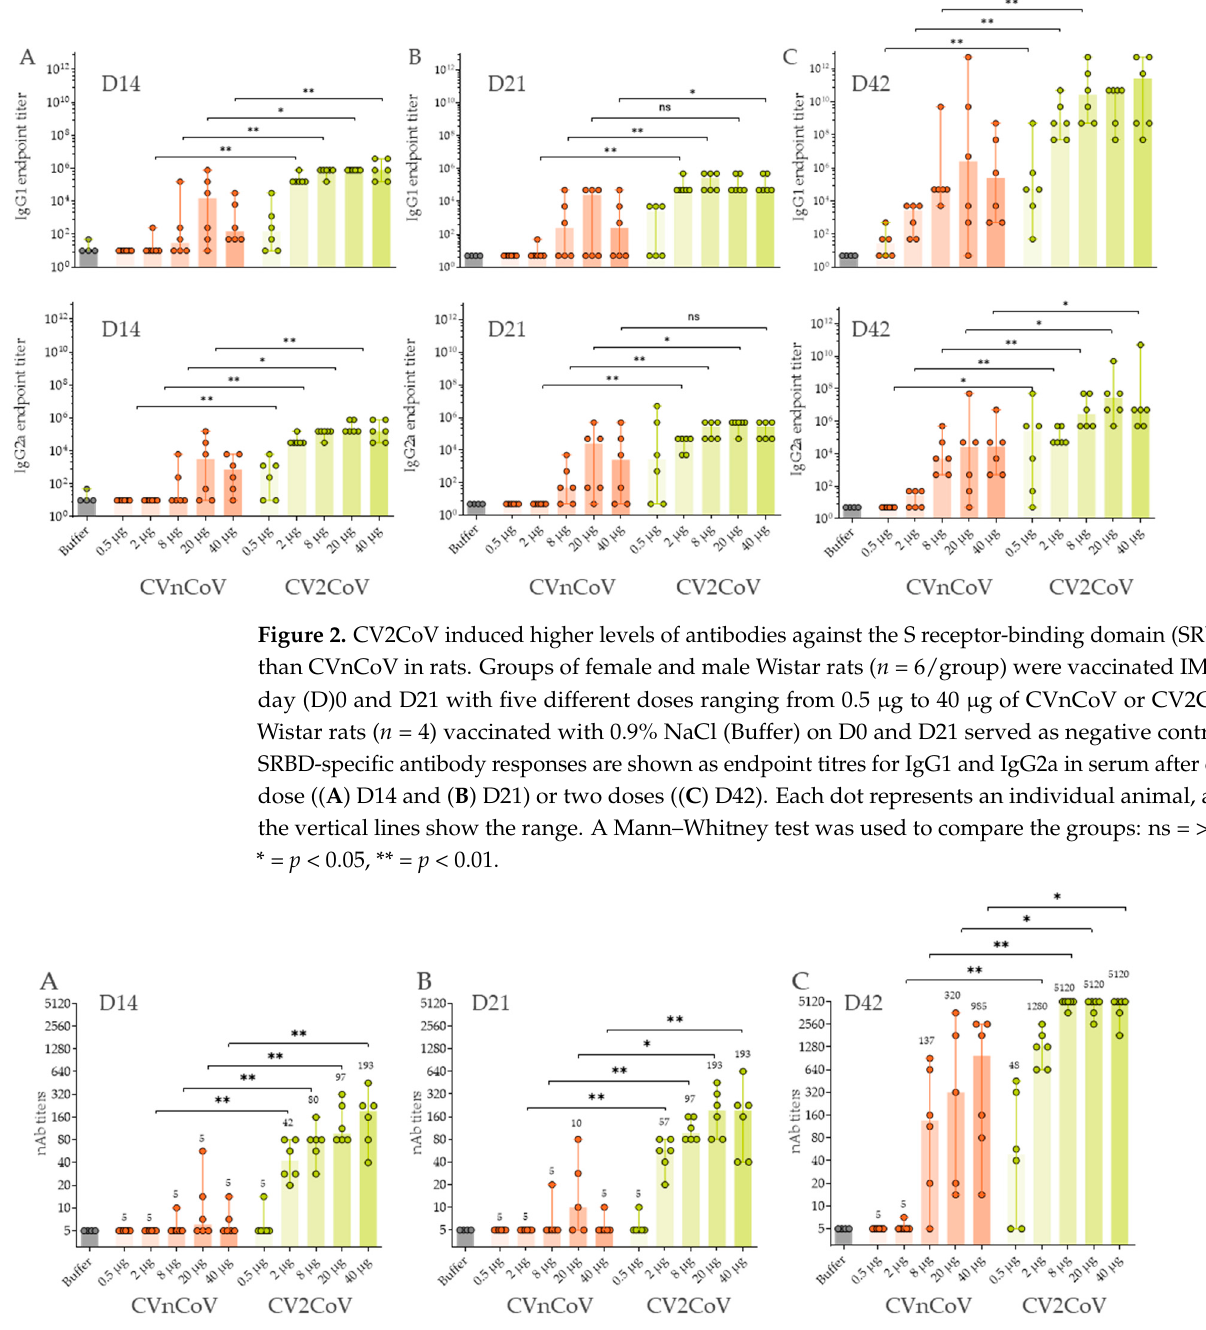
Figure 3. CV2CoV induced higher virus neutralising antibody (nAb) titres against ancestral SARS ‐ CoV ‐ 2 than CVnCoV. Groups of female and male Wistar rats ( n = 6/group) were vaccinated IM with five different doses ranging from 0.5 μ g to 40 μ g of CVnCoV or CV2CoV on D0 and D21. Rats ( n = 4) vaccinated with 0.9% NaCl (buffer) served as negative controls. SARS ‐ CoV ‐ 2 virus neutralising antibody (nAb) titres in serum samples taken on ( A ) D14, ( B ) D21 and ( C ) D42 were analysed. The highest dilution was 1:5120. Each dot represents an individual animal, and vertical lines show the range. Mann ‐ Whitney test was used to compare groups. * = p < 0.05, ** = p < 0.01. CV2CoV doses of >2 μ g induced higher virus nAb titres than 20 μ g of CVnCoV